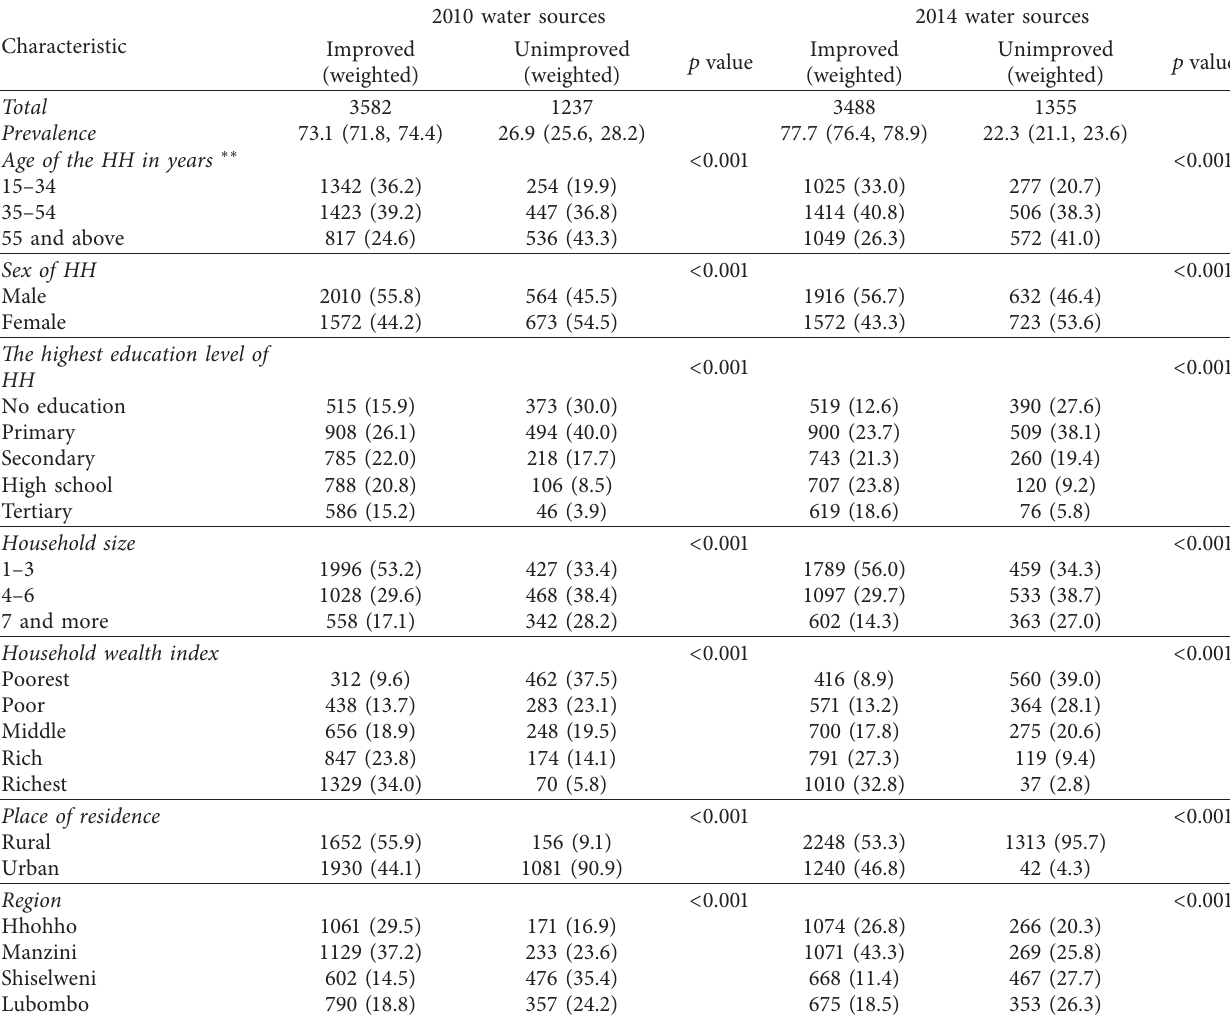
Table 2: Distribution of household characteristics by access to improved drinking water sources in each survey